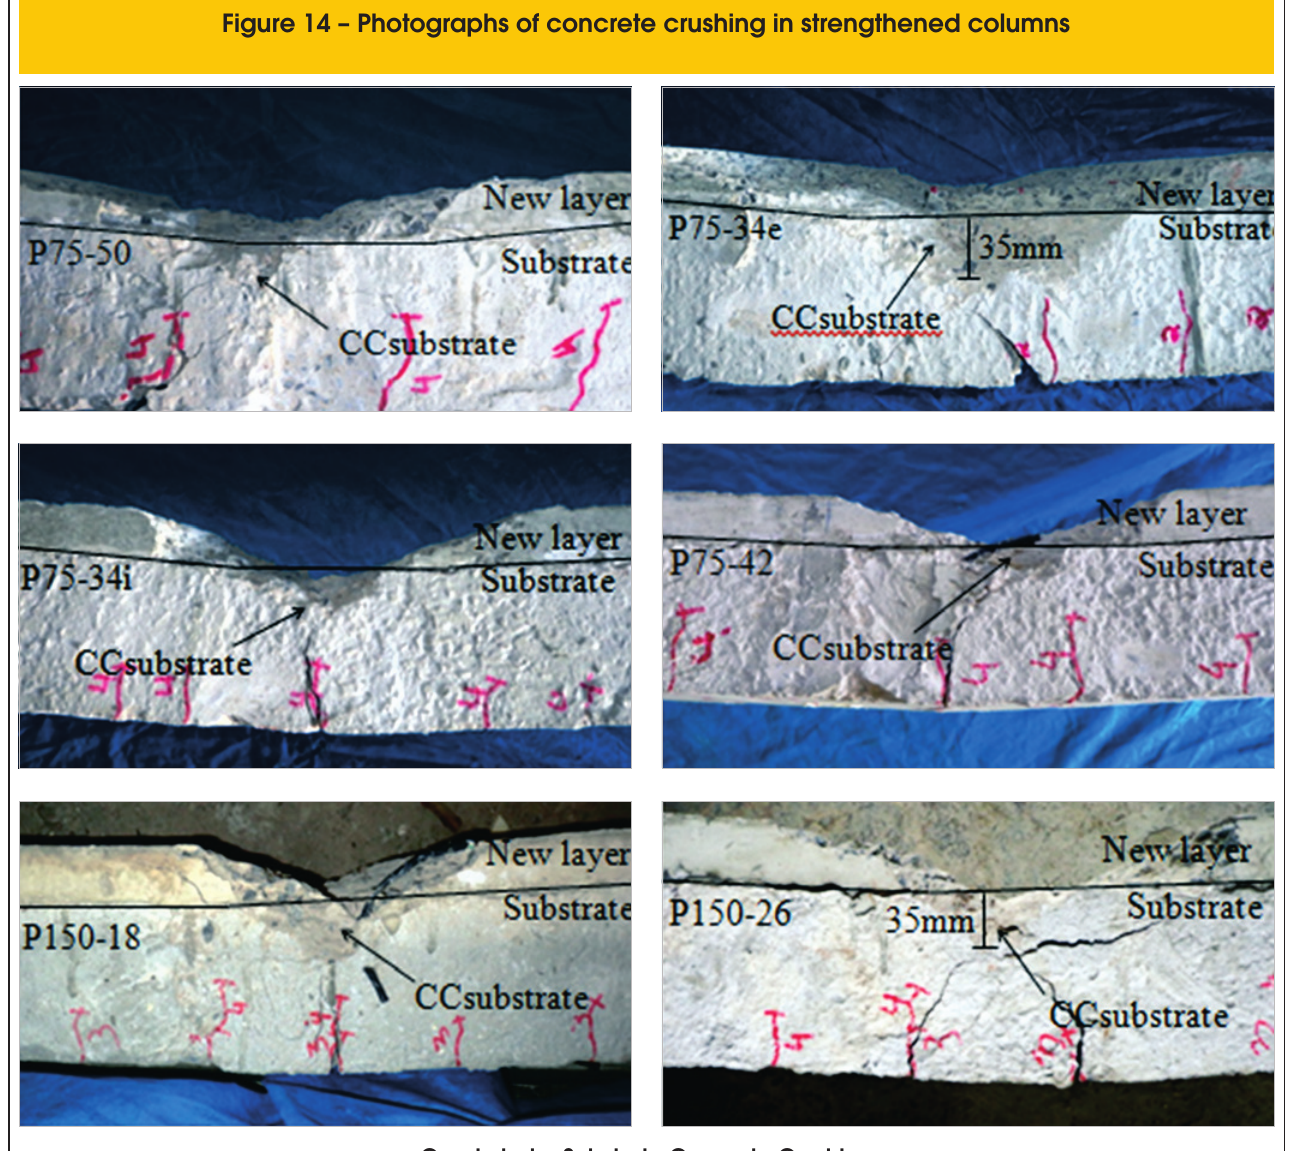
Figure 14 – Photographs of concrete crushing in strengthened